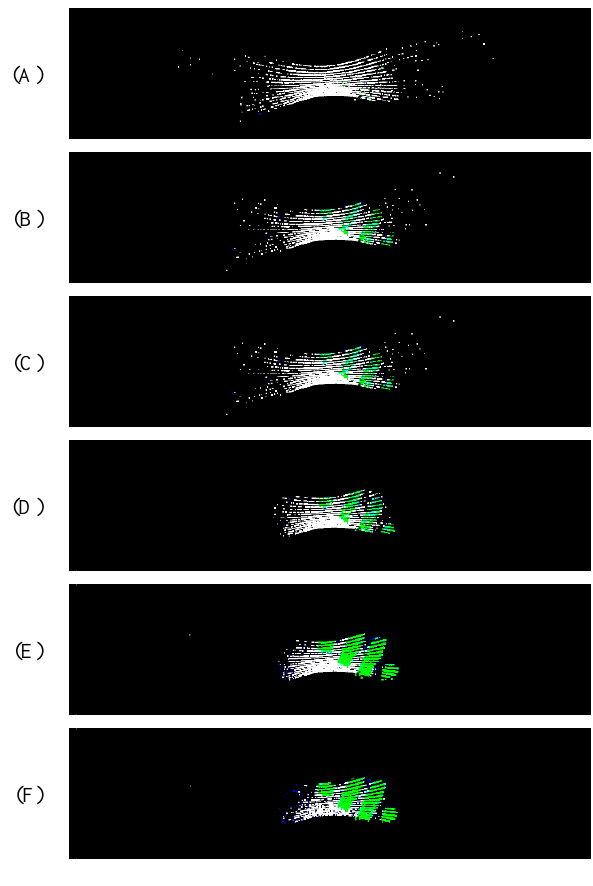
Figure 6. Sample Inference